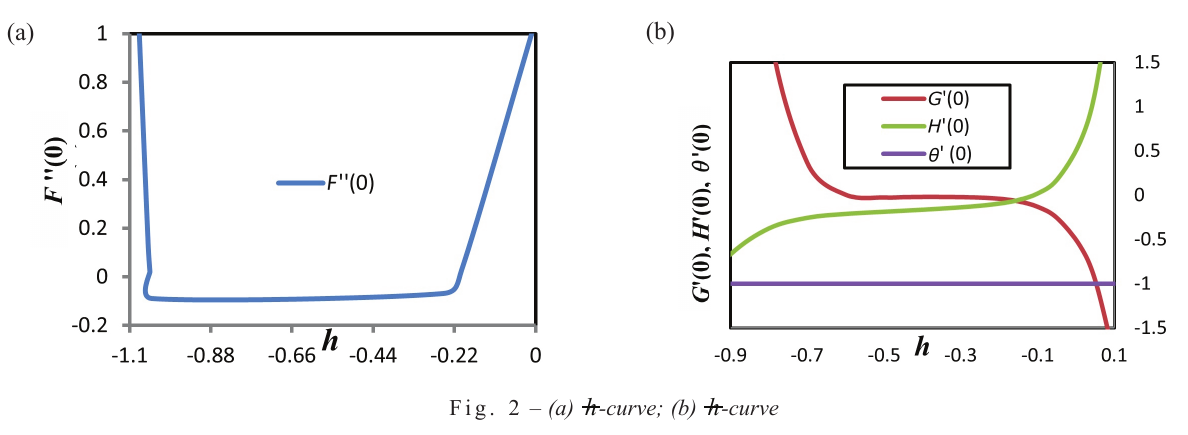
Fig. 2 – (a) h -curve; (b) h -curve